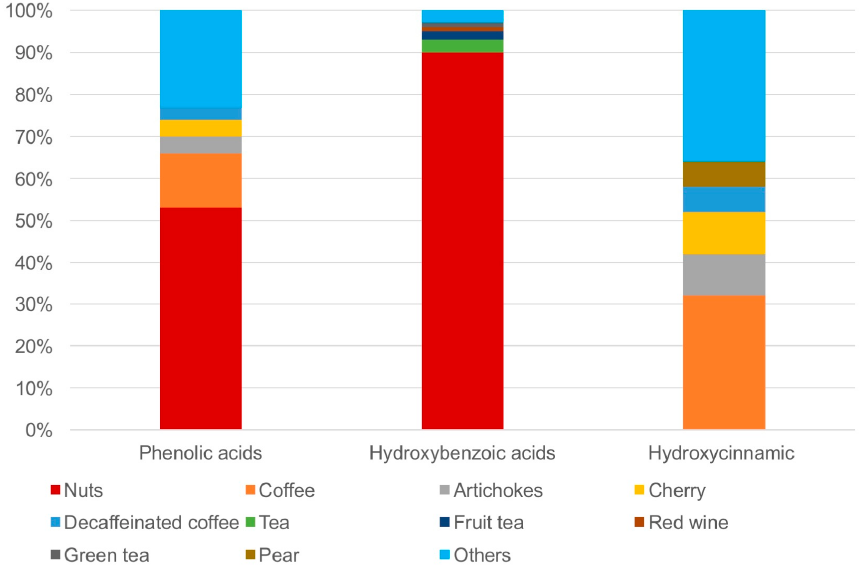
Figure 1. Distribution of major dietary sources of phenolics in the all cohort.